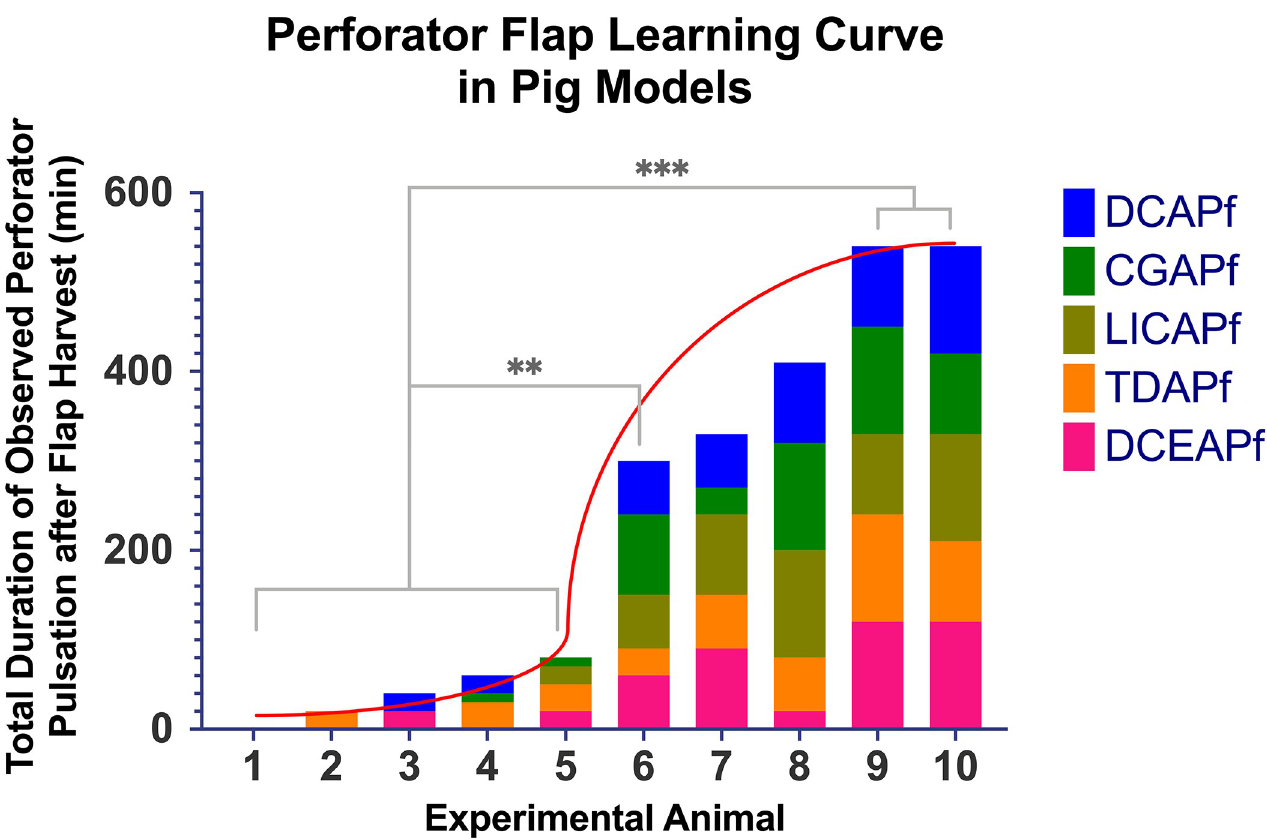
Fig 9. Plotting of the perforator flap learning curve (red) in pig models by aggregating the total duration of observed perforator pulsation after dissection of the perforator flap. A longer observed pulsation implies a better surgical outcome. ns marks no significant statistical difference; � marks a significant statistical difference, with P < 0.05; �� marks a very significant statistical difference, with P < 0.01; ��� marks a highly significant statistical difference, with P < 0.001.